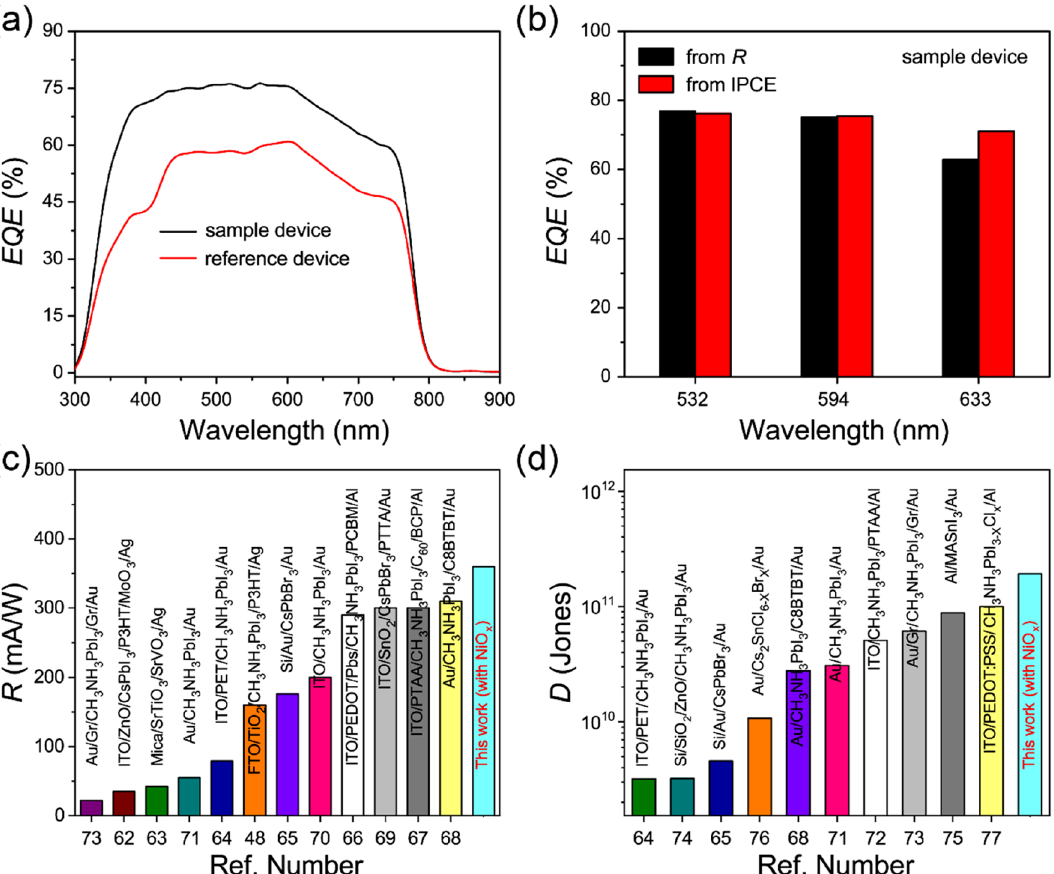
Figure 7. ( a ) EQE spectra as a function of the wavelength for the perovskite photodiodes with NiO x or PEDOT:PSS as HTLs, ( b ) comparison of measured (from IPCE) and estimated (from R ) values of the EQE s at zero bias voltage for three different wavelengths of incident light, and comparisons of the R ( c ) and D ( d ) values of several previously reported perovskite